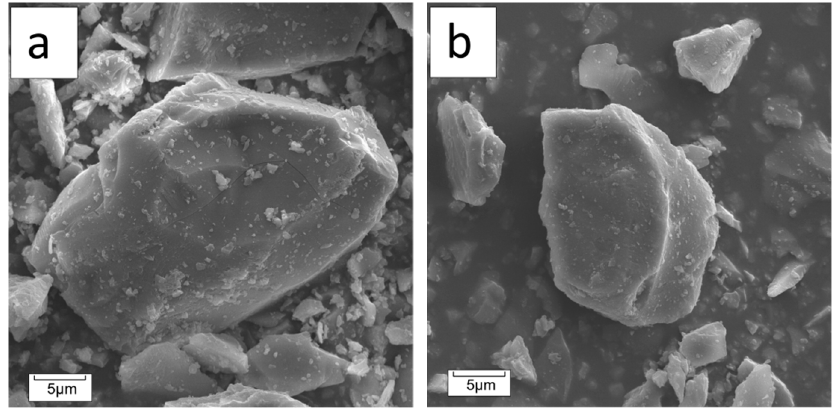
Figure 2. X-ray diffraction (XRD) analysis of ceramic polishing powder and quartz powder.